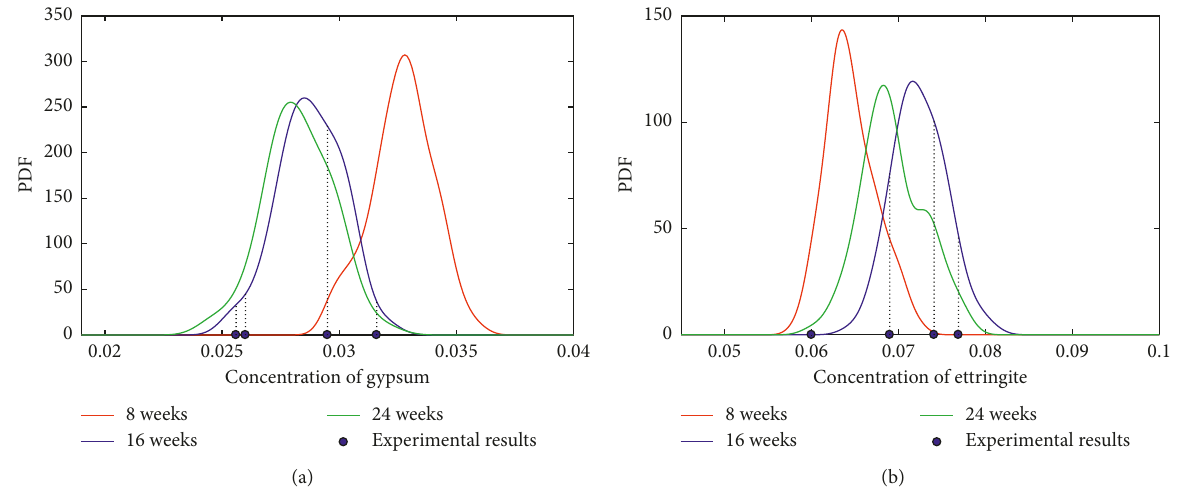
Figure 9: PDF curves of the concentrations of (a) gypsum and (b)